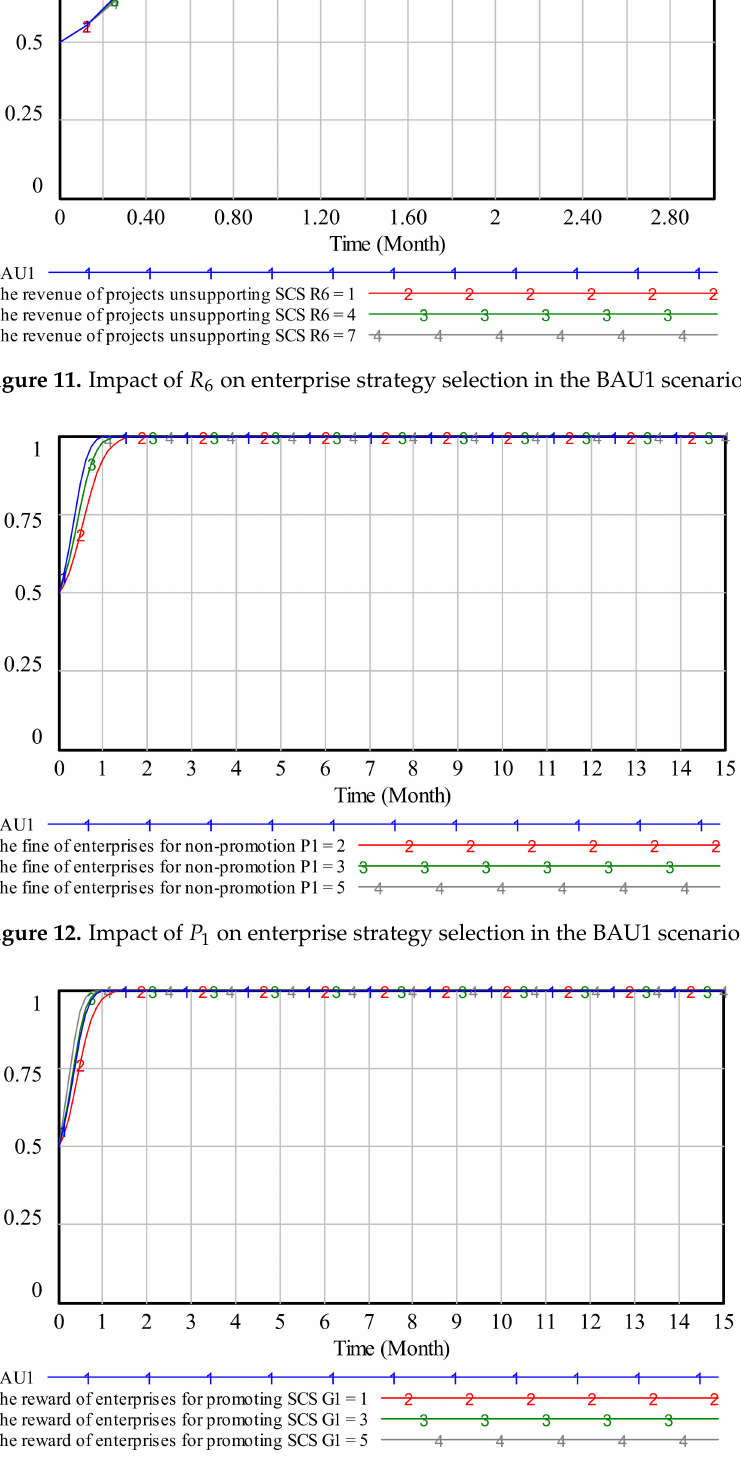
Figure 13. Impact of G 1 on project strategy selection in the BAU1